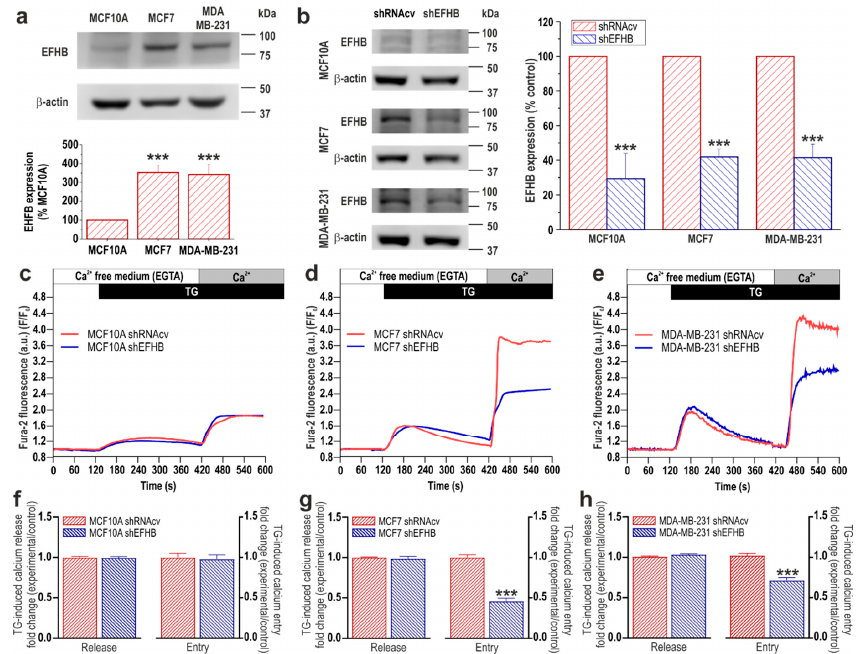
Figure 1. EFHB is expressed in breast cancer and pre-neoplastic epithelial cells and plays a relevant role in SOCE. ( a ) MCF10A, MCF7, and MDA-MB-231 cells were lysed and analyzed using Western blotting with a specific anti-EFHB antibody. The membrane was reprobed with an anti- β -actin antibody for protein loading control. Bar graphs represent EFHB expression normalized to the β -actin content and expressed as percentage of the expression in MCF10A cells. Molecular masses indicated on the right were determined using molecular-mass markers run in the same gel. *** p < 0.001 compared to EFHB expression in MCF10A cells. ( b ) MCF10A, MCF7, and MDA-MB-231 cells were transfected with shEFHB or scramble plasmids (shRNAcv), as indicated. After 48 h cells were lysed and analyzed using Western blotting with an anti-EFHB antibody, followed by reprobing with an anti- β -actin antibody for protein loading control. Bar graphs represent EFHB expression normalized to the β -actin content at the different experimental conditions and expressed as percentage of the expression in shRNAcv-treated cells (control). *** p < 0.001 compared to EFHB expression in shRNAcv-treated